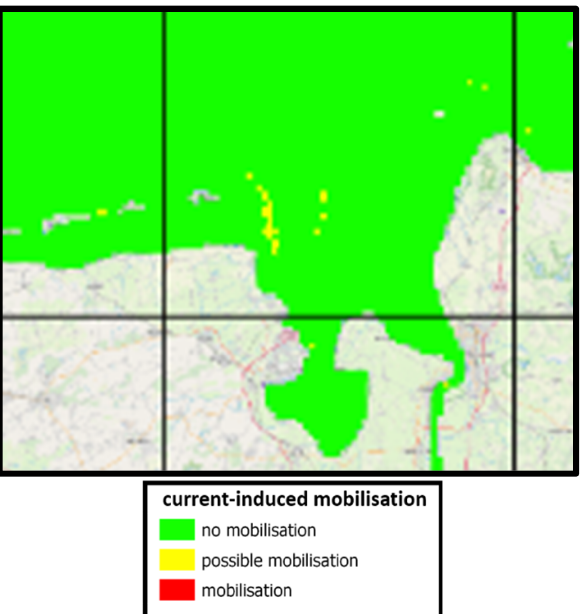
and the German mine type GY in EPSG: 25832-ETRS89/UTM Zone 32 N.